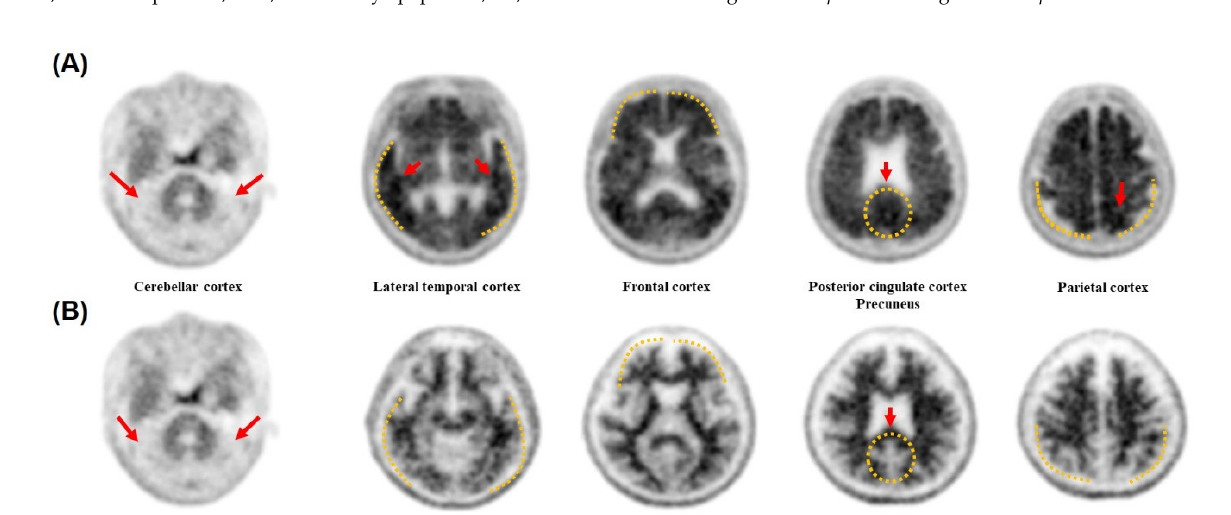
Figure 7. Comparison of the ELISA and peptide systems using the CSF samples. ( A ) The average of the A β 42 signals estimated using ELISA and the results of the unpaired t -test comparing the positive and negative categories (**** p ≤ 0.0001). ( B ) Box plot of the A β 42 signal distributions in each group using ELISA (**** p ≤ 0.0001). ( C ) The average of the A β 42 signals estimated using the ABPP-based method and the results of the unpaired t -test comparing the positive and negative categories (** p ≤ 0.01). ( D ) Box plot of the A β 42 signal distributions in each group using the ABPP-based method (** p ≤ 0.01).